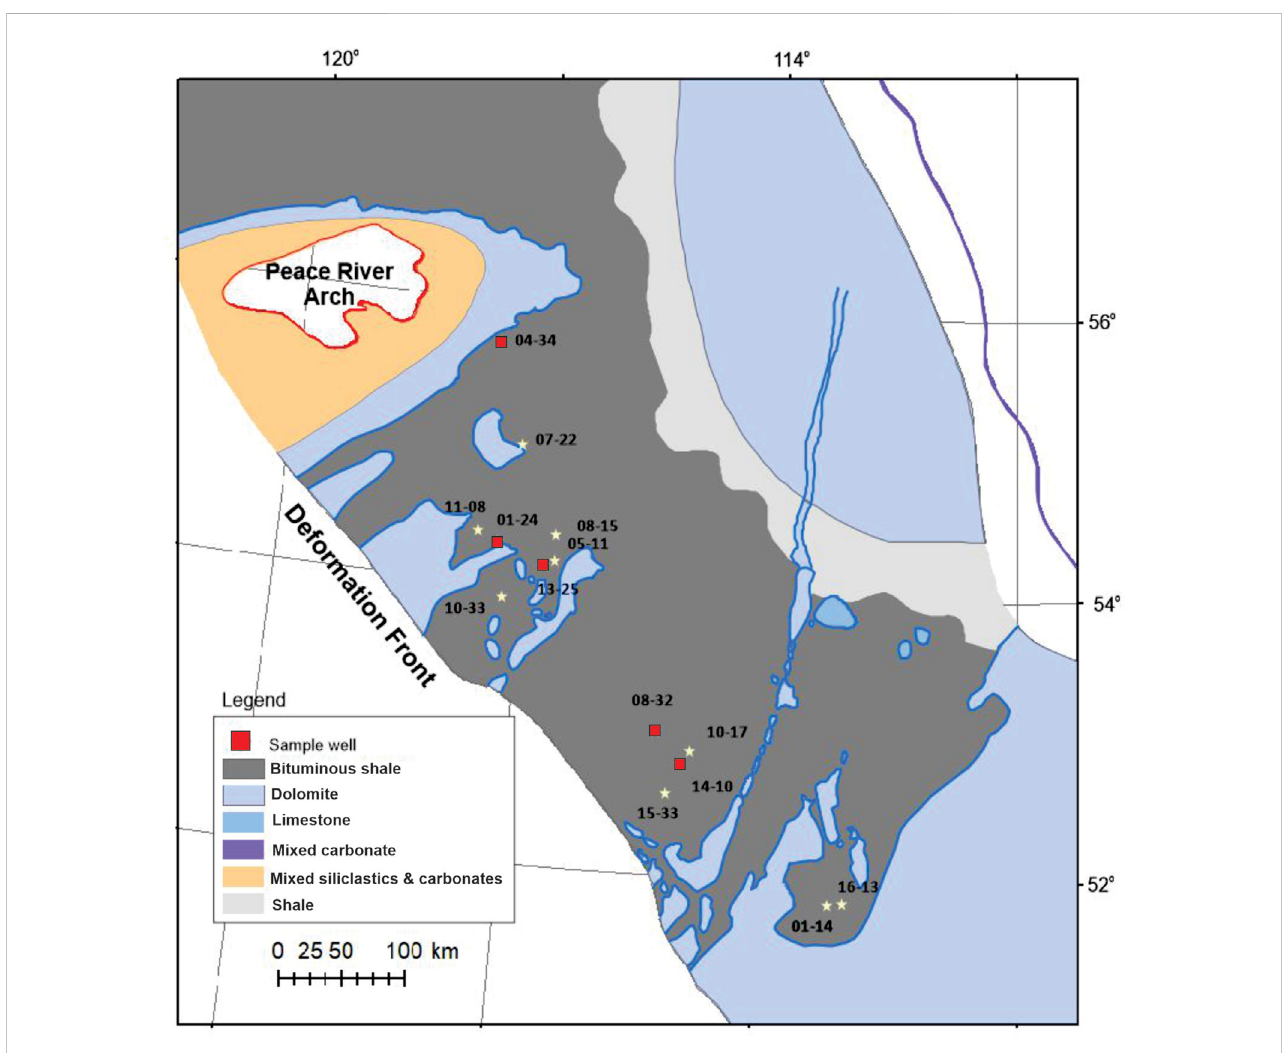
FIGURE 1 Location of the study area and core sample well locations in this study (modi fi ed from Switzer et al., 1994). Well names and major bulk geochemical features of the samples are provided in Table 1 (last column: well ID in